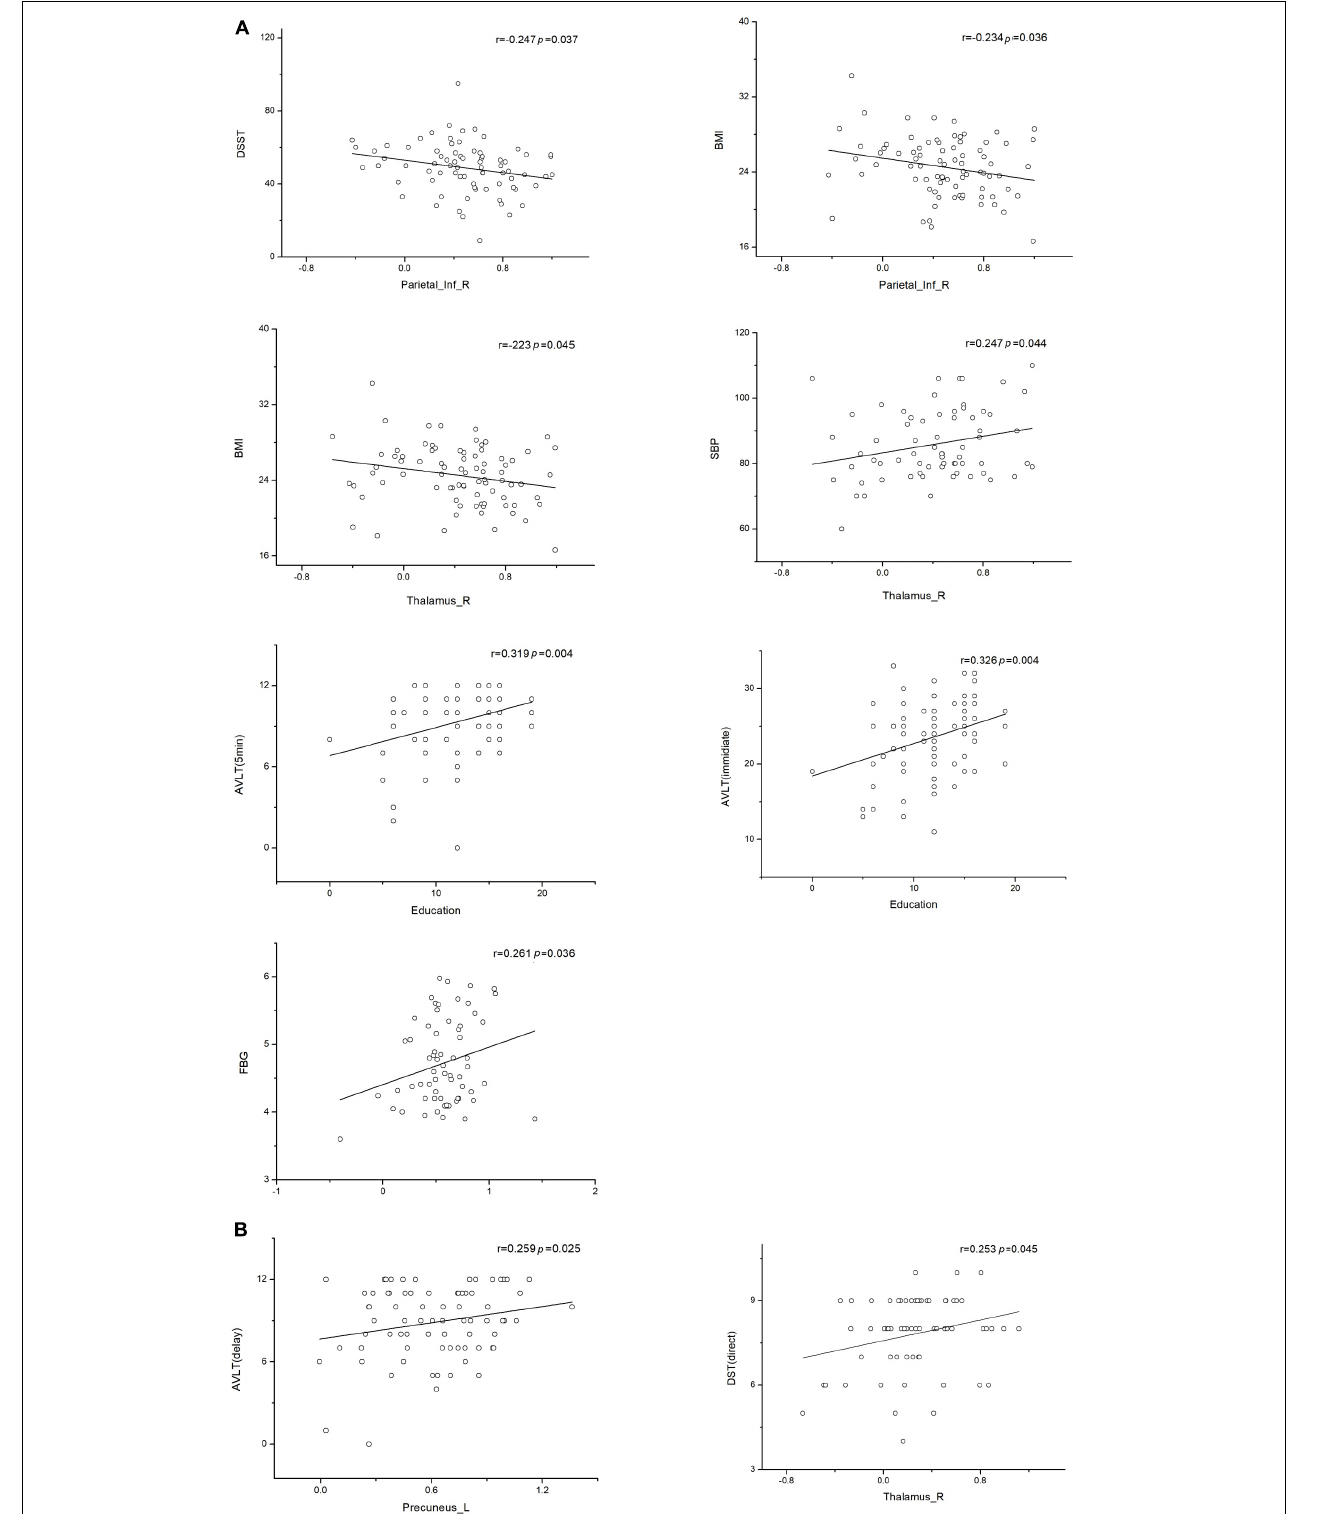
FIGURE 6 | Associations between functional connectivity and neuropsychological test scores. Pearson correlation was conducted on functional connectivity and neuropsychological test scores. (A) Correlation of functional connectivity with neuropsychological test scores in the type 2 diabetes mellitus group. (B) Correlation of functional connectivity with neuropsychological test scores in the normal control group ( p < 0.05 indicates statistically significant differences). L, left; R, right.